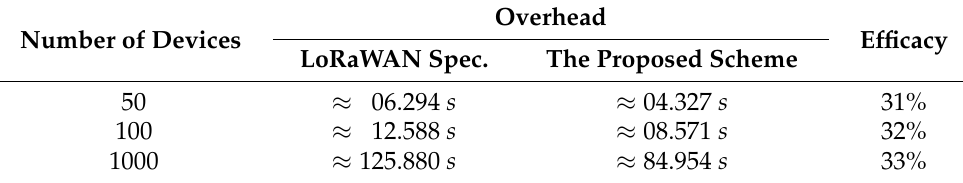
Table 5. Performance